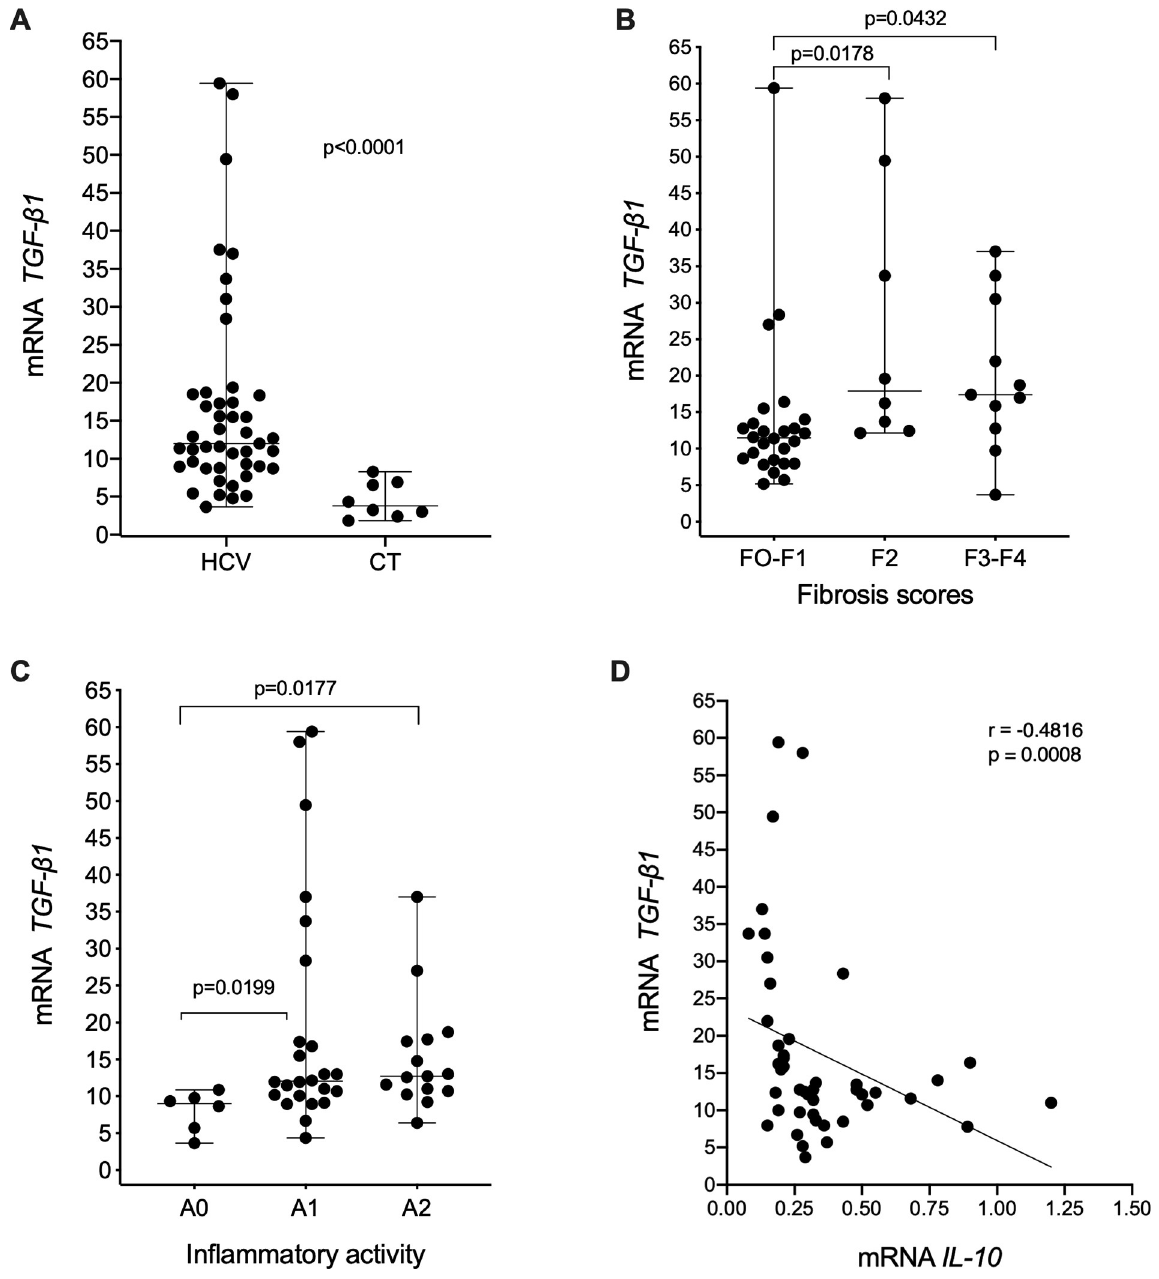
Fig 5. TGF β 1 mRNA level according to the clinical condition of the liver and its correlation with the IL10 mRNA level. A-C: Intrahepatic TGF β 1 expression between HCV and CT patients (Mann-Whitney test) and between patients with different fibrosis scores and with different necroinflammatory activity levels (Kruskal-Wallis test). D: Spearman’s correlation analysis between TGFB1 and IL10 mRNA levels.